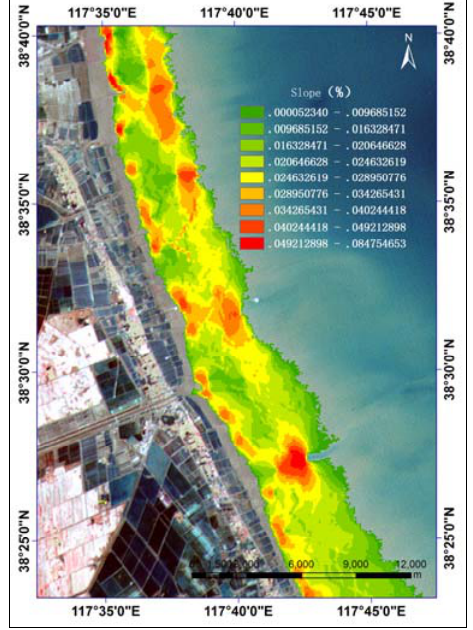
Figure.9 showed the cartographic fruit of the slope of mudflat of Bohai Bay. The slope was expressed as percent or the ratio of elevation increment and horizontal distance. Results showed that the overall slope of the Bohai Bay tidal flat was gently sloping, between 0.016% and 0.08%, the average slope was 0.48 ‰ . Analysis from the remote sensing images and the